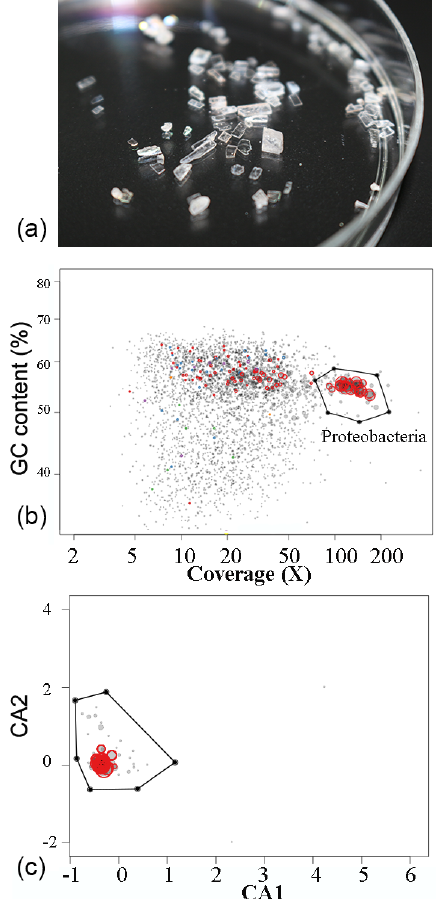
Figure 1. Anhydrite crystals and genome binning. Anhydrite crys- tals in a Petri dish (90mm in diameter) (a) were used for DNA extraction. The amplified genomic DNA was sequenced and then reassembled. Based on the G + C content and read coverage, the binned contigs with high coverage levels (b) were selected for ex- amination of the tetranucleotide frequency consistency in the PCA analysis (c)